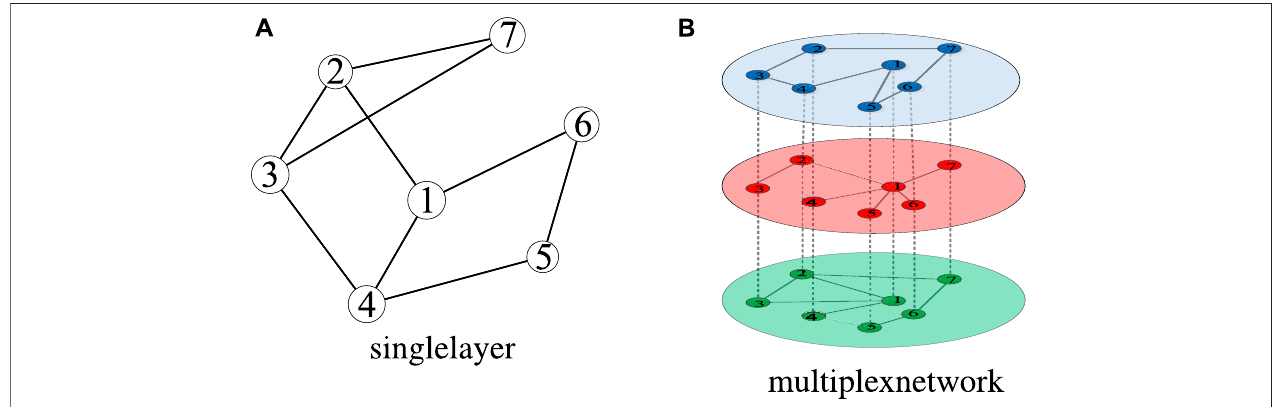
FIGURE1| Single-layer andmultiplex networks withthesame setofnodesbut differentlinktypes. (A) Thesingle-layernetwork. (B) Differentnodesareconnected to each other by a continuous line in each relationship. A single node is connected to its counterparts by a dashed line.